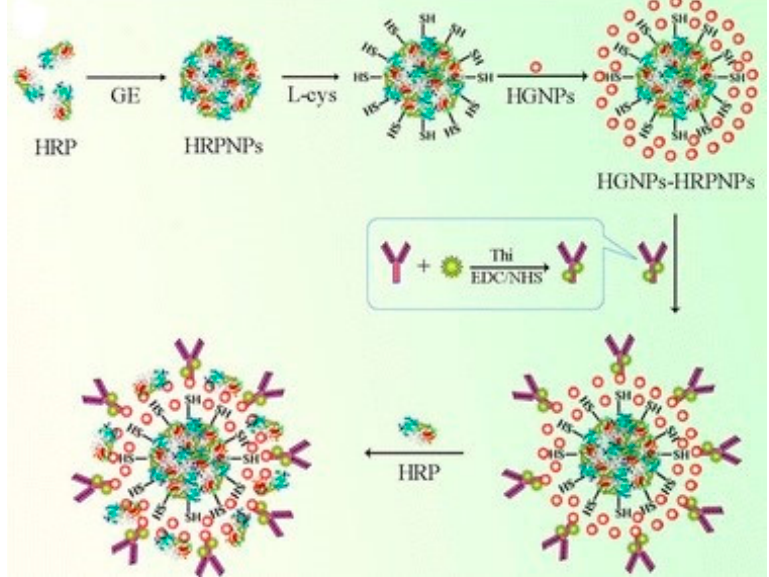
Figure 4. Synthesis process of hollow Au-NPs-HRP-NPs and preparation procedure of HRP-hollow Au-NPs-HRP-NPs-Thi@Ab2 bioconjugate. Reproduced with permission from [40].